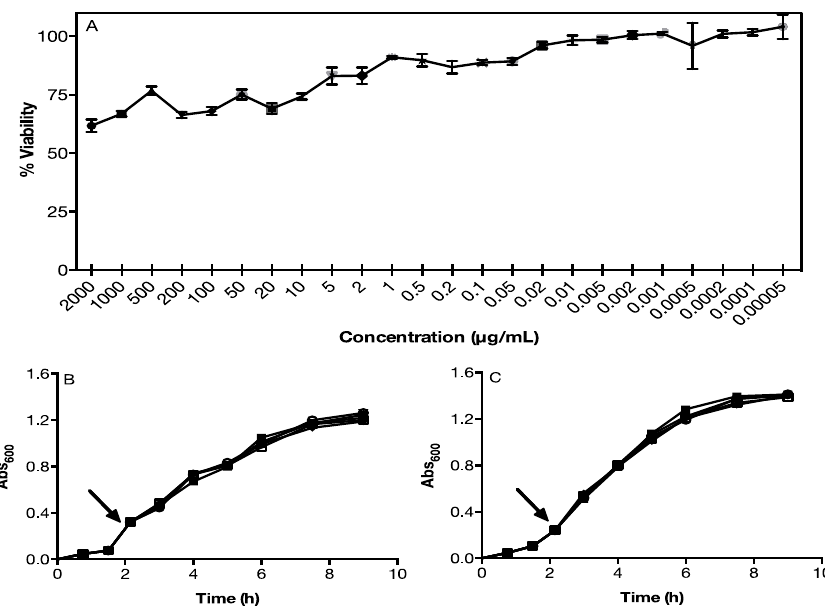
Figure 4. Toxicity of biomimetic NPs. ( A ) MTS viability assay on OKF6-TERT2 cells exposed to different concentrations of NPs. ( B ) Bacterial growth curves of Staphylococcus aureus and ( C ) Escherichia coli in the presence of different concentrations of NPs (the arrow indicates the time in which NPs were incorporated). Control without copper ( ● ) 100 μ g/mL ( ■ ), 500 μ g/mL ( ○ ), 1.000 μ g/mL ( □ ), and 2.000 μ g/mL ( ♦ ) CuCl 2 .